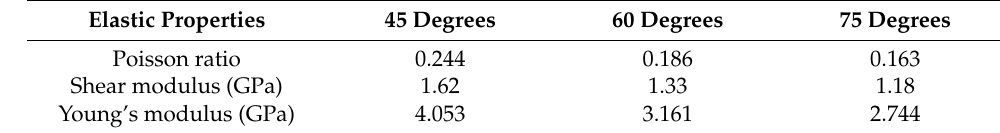
Table 5. Ceramic/Epoxy sample reading at varying